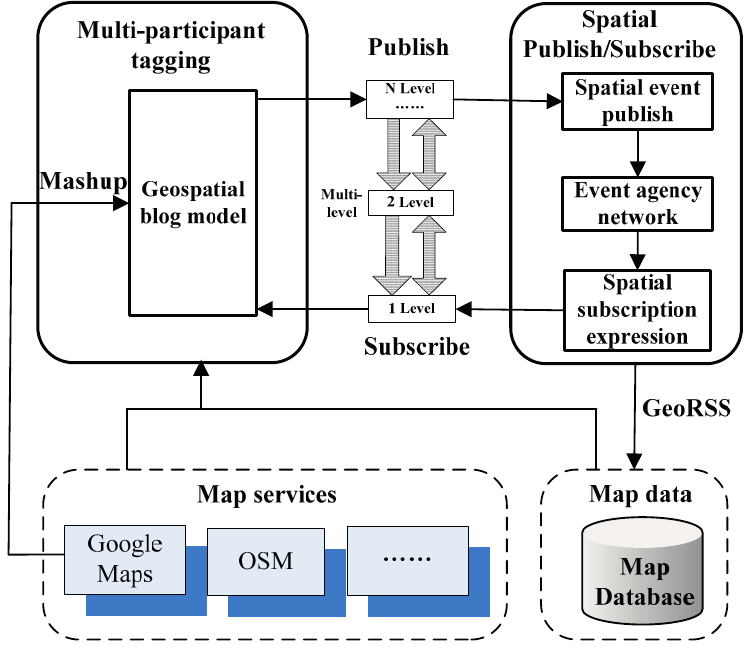
Figure 1. The general scheme of the tagging